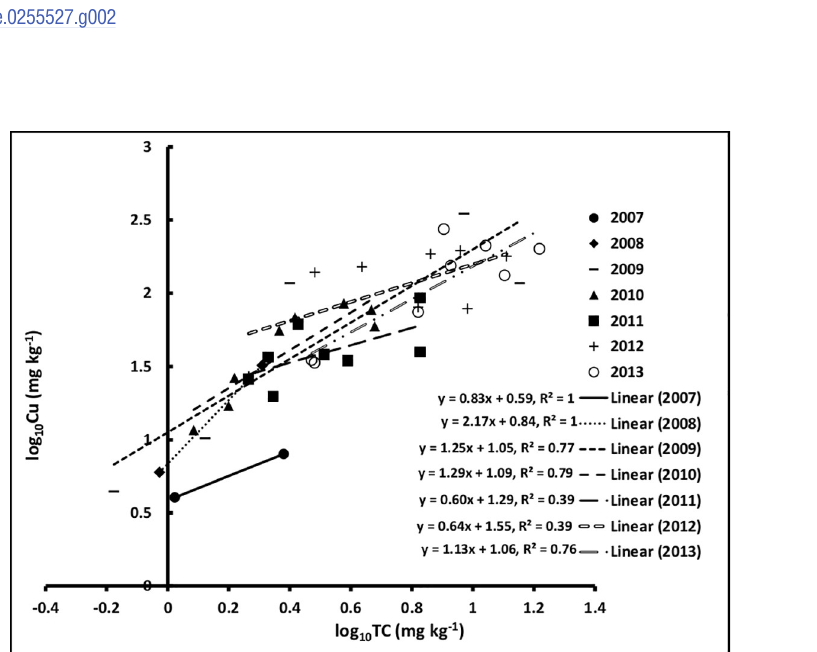
Fig 3. The effect of the interaction between year and log 10 TC on log 10 Cu.